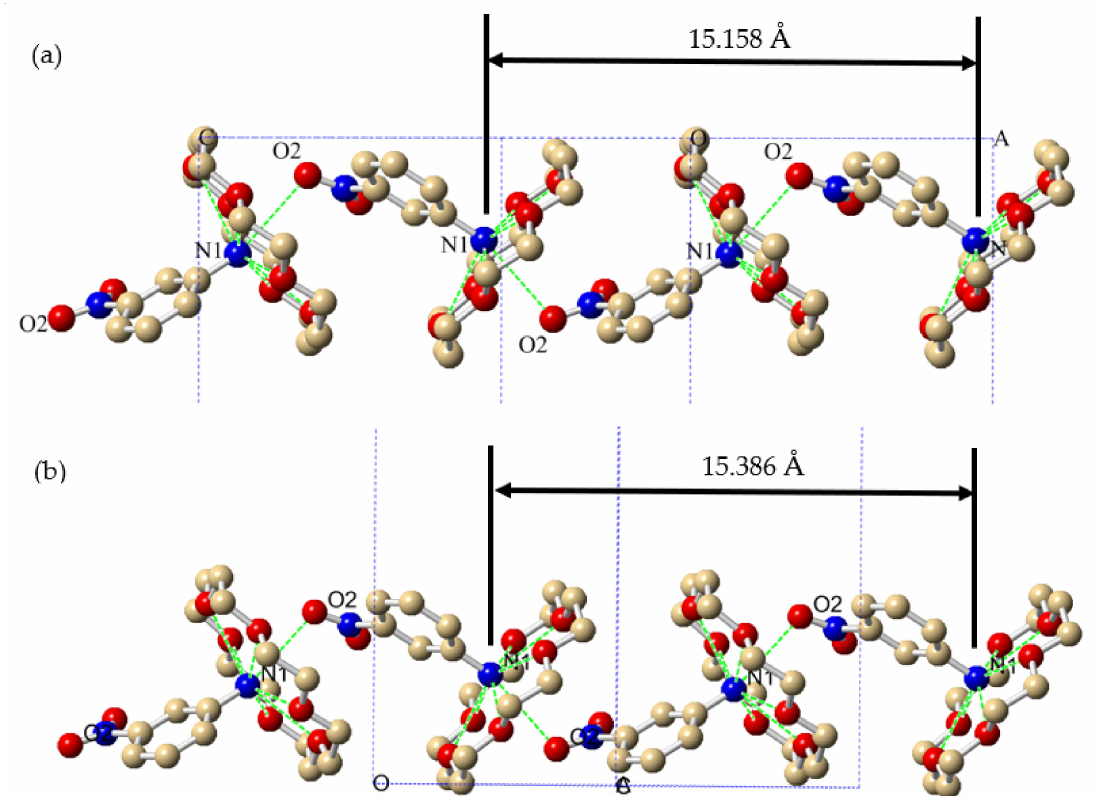
Figure 3. ( a ) One-dimensional hydrogen bond chains in the room-temperature phase viewed along the a -axis. The distance between two adjacent (3-nitroanilinium) (18-crown) cations was determined as 15.158 Å. ( b ) Hydrogen bond chains in the low-temperature phase viewed along the ( a + c )-axis with the distance between two adjacent (3-nitroanilinium) (18-crown) cations determined as 15.386